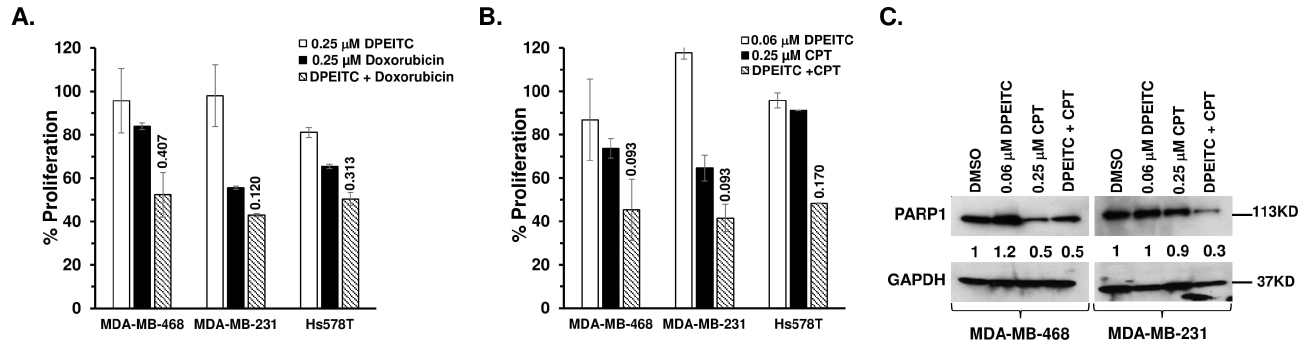
Figure 7. DPEITC enhances p53 mutant TNBC cell’s sensitivity to topoisomerase inhibitors. ( A ) MDA-MB-468 (p53 R273H ), MDA-MB-231 (p53 R280K ), or Hs578T (p53 V157F ) cells were treated with DPEITC, CPT, or both for 24 h. ( B ) MDA-MB-468 (p53 R273H ), MDA-MB-231 (p53 R280K ), or Hs578T (p53 V157F ) cells were treated with DPEITC, doxorubicin, or both for 72 h. Percent cell proliferation was determined by the WST-1 assay. Experiments were performed in triplicate. Error bars represent SD. ( C ) Effects of DPEITC on PARP1 levels. MDA-MB-468 (p53 R273H ) or MDA-MB-231 (p53 R280K ) cells were treated with DPEITC, CPT, or both for 24 h. In total, 100 μg of the cell lysate fractions were resolved by SDS-PAGE and probed with an anti-PARP antibody. Blots were